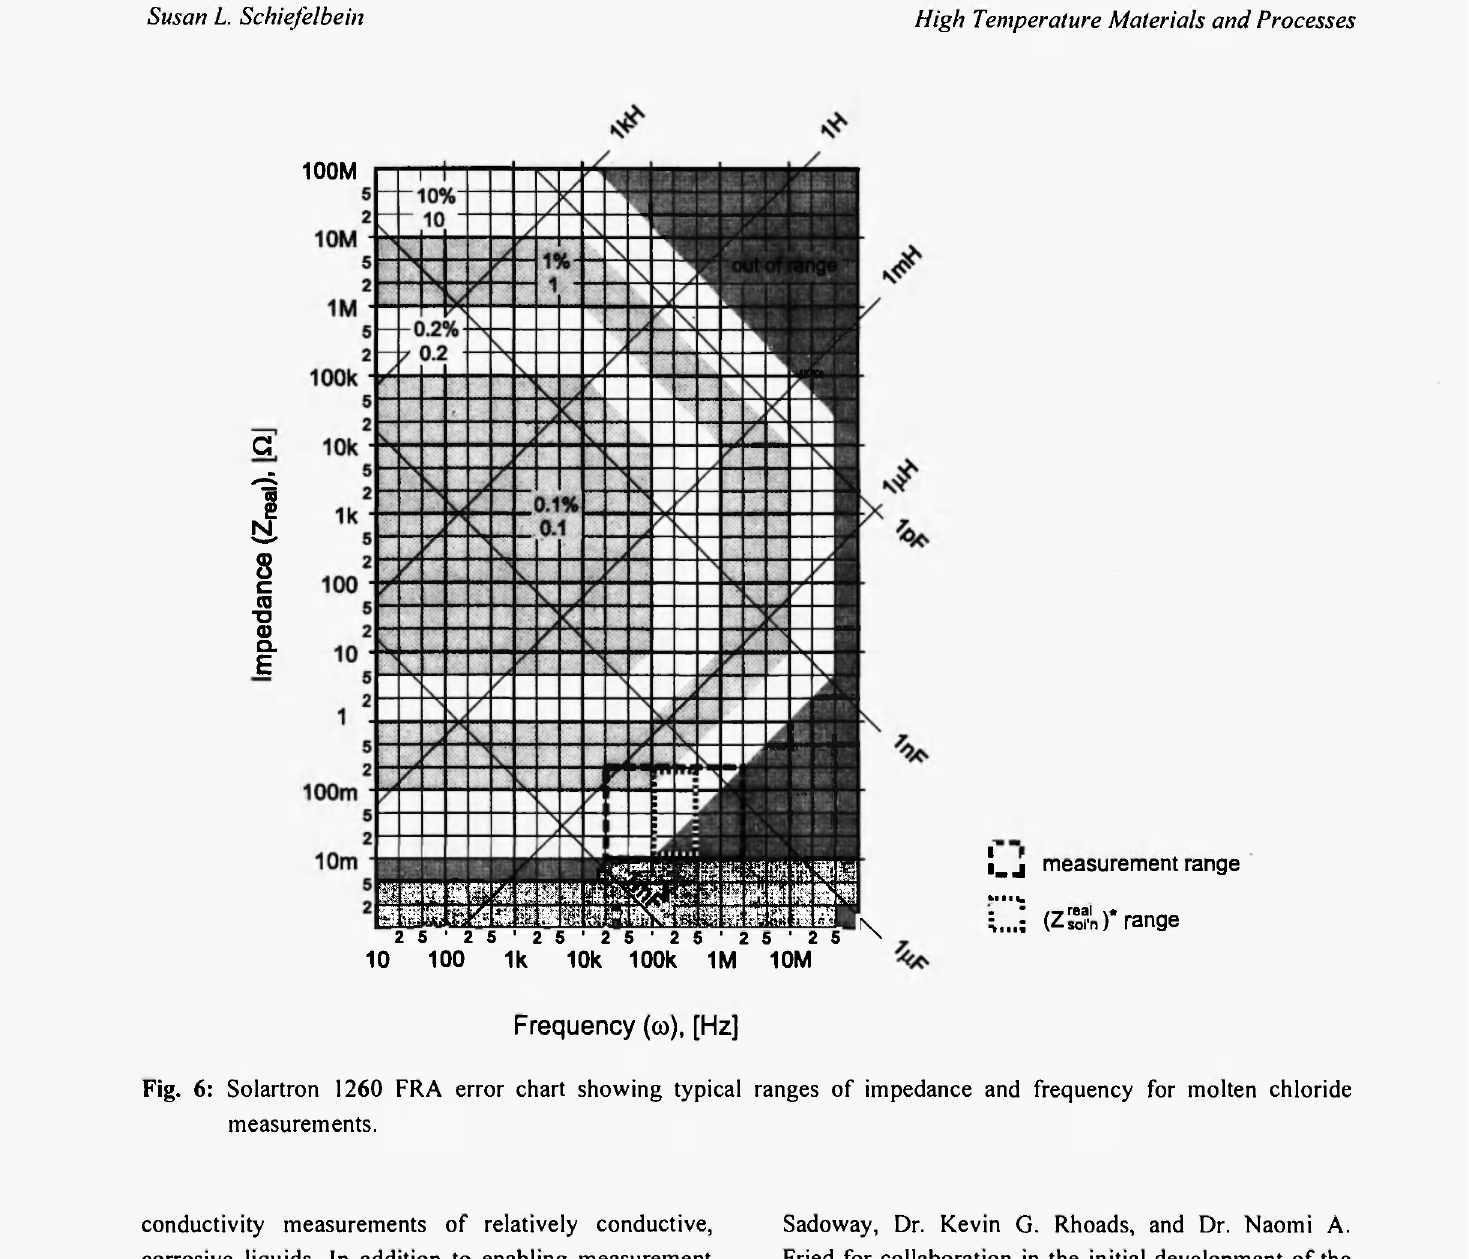
Fig. 6: Solartron 1260 FRA error chart showing typical ranges of impedance and frequency for molten chloride